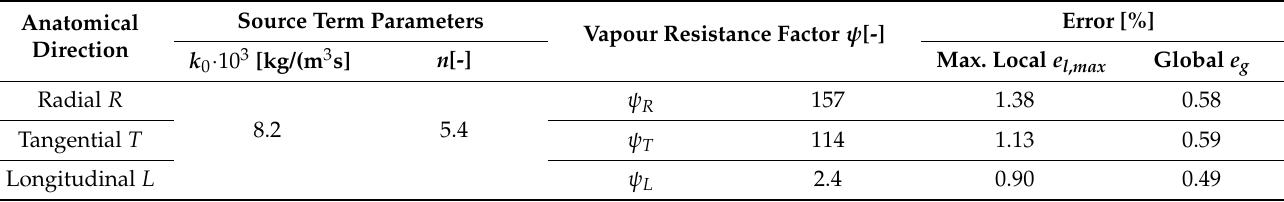
Table 5. Model coefficients and matching errors for larch.